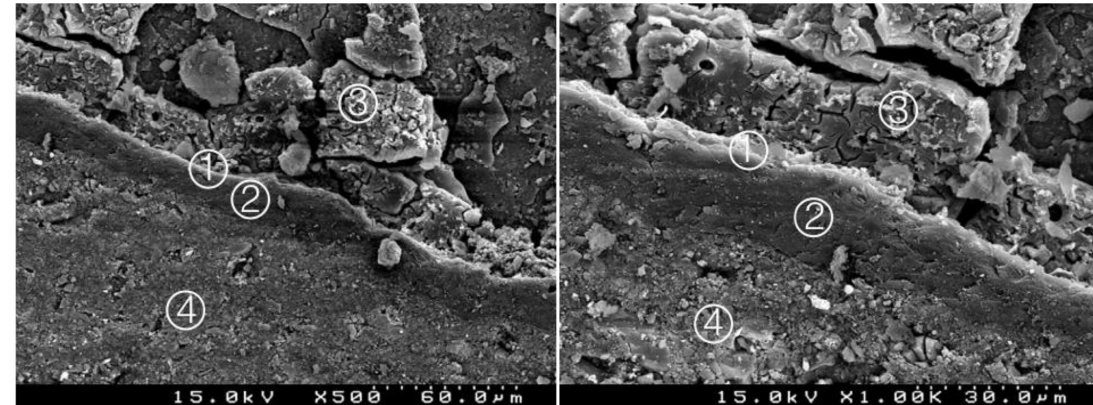
Figure 8. Group 6 (BiodentineU07): some interdigitation between the adhesive and cement. A less deep hybrid layer is observed 1 (cid:13) between the adhesive 2 (cid:13) and the Biodentine TM 3 (cid:13) . Composite resin 4 (cid:13) (original magnification 500 × and 1000 × ).